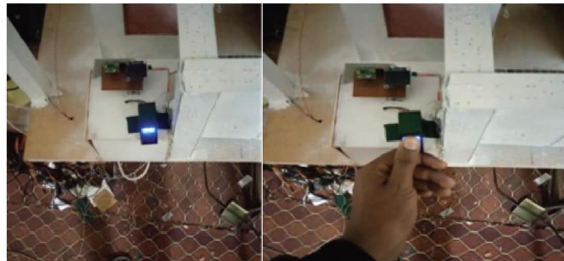
Figure 10: Using a fnger print to open a